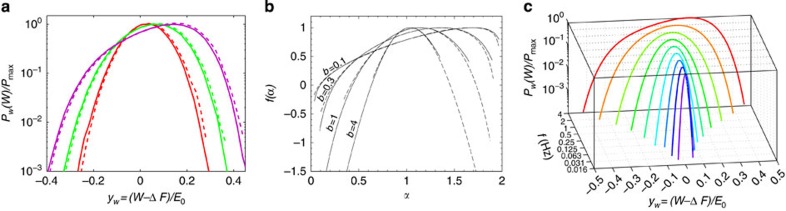
Comparison of distributions of dissipated work and amplitudes of random multifractal wavefunctions.(a) Distribution of the measured normalized dissipated work (W−ΔF)/E0 on the logarithmic scale. The width of the distributions increases with increasing drive frequency f=1 (red), 2 (green) and 4 Hz (violet) at temperature T=214 mK. (b) Multifractality spectrum f(α) of critical eigenfunctions in disordered systems close to the Anderson localization transition versus normalized logarithm of wavefunction intensity  for the power-law random banded matrix model with the bandwidth b=0.1, 0.3, 1, 4 (adapted with permission from ref. 21. Copyrighted by the American Physical Society). This parameter is known to mimic the dimensionality of space in which the Anderson transition happens: b→0 corresponds to the limit of infinite dimensionality d→∞, or the Bethe lattice limit, while b→∞ corresponds to d=2+ɛ, where ɛ →+0. In both a and b, solid and dashed lines correspond to G(y), G(−y)−y and f(α), f(2−α)+α−1, respectively, to demonstrate the symmetry (equation (3)). (c) Evolution of distribution of the normalized dissipated work (W−ΔF)/E0 on the logarithmic scale with decreasing drive frequency f in a SEB with a superconducting external electrode for experimental system parameters and T=214 mK obtained theoretically from the rate equations (equations (3) and (4) in the Supplementary Note 1). The width of the distributions decreases with decreasing driving frequency f (from red to violet curve). The similar calculations for the SEB with the normal electrode give , where τ0 is the characteristic relaxation time of the circuit. Thus an effective bandwidth b of the equivalent random matrix theory depends on the equivalent size of the matrix N=exp(E0/kBT). While the limit T→0 always corresponds to the limit b→0, the limit f→0 at a fixed T corresponds to the adiabatic limit b→∞.